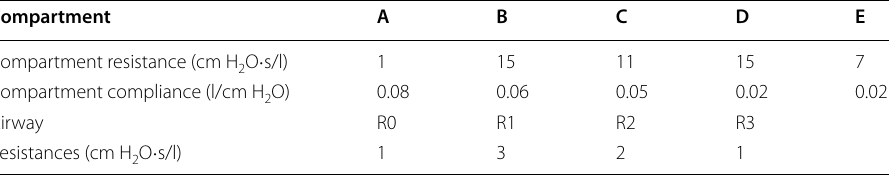
Table 1 Table of parameter values used throughout simulations unless otherwise stated